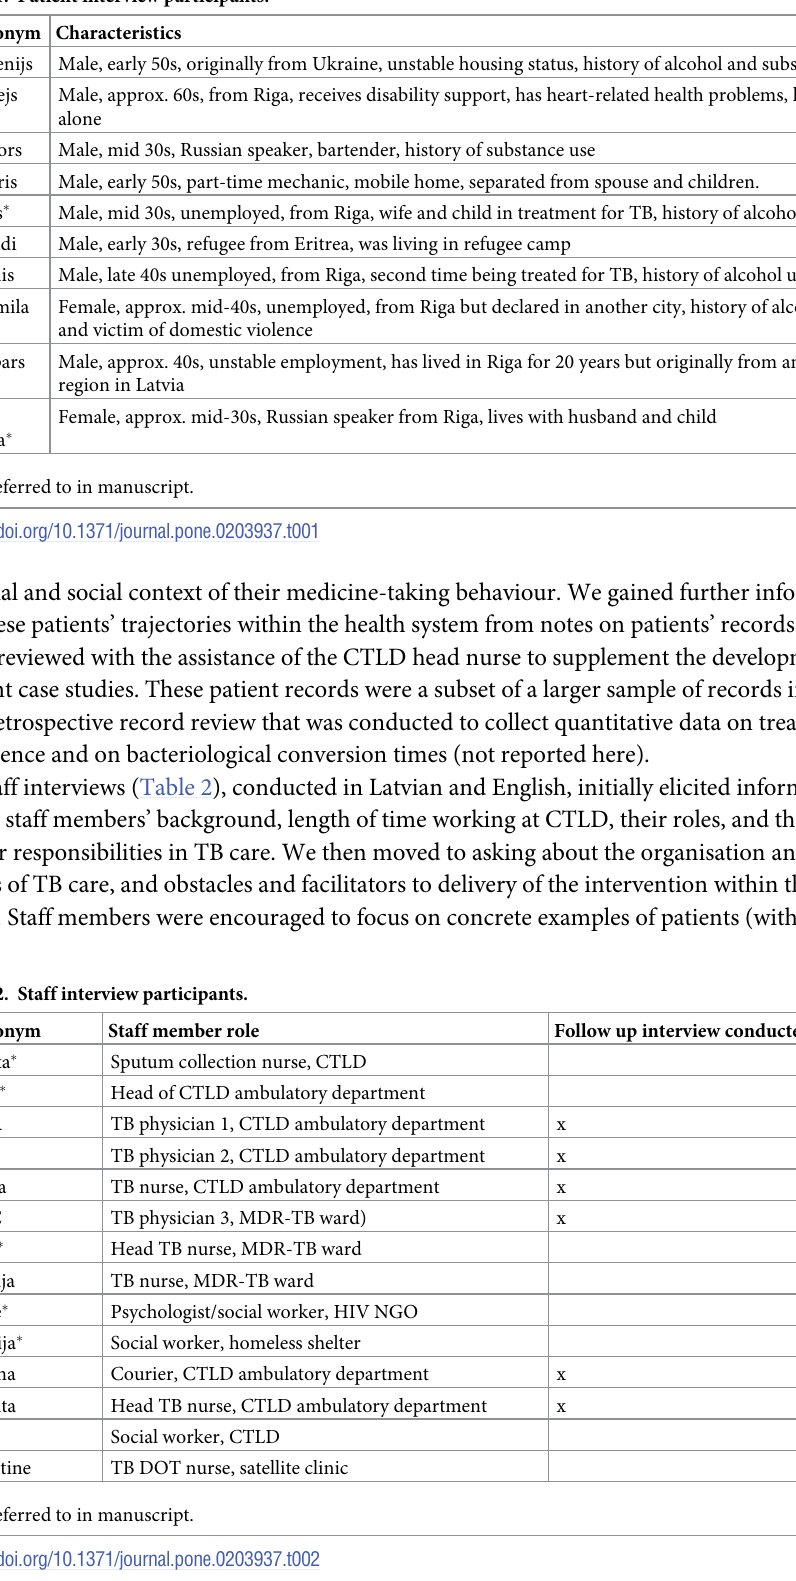
Table 1. Patient interview